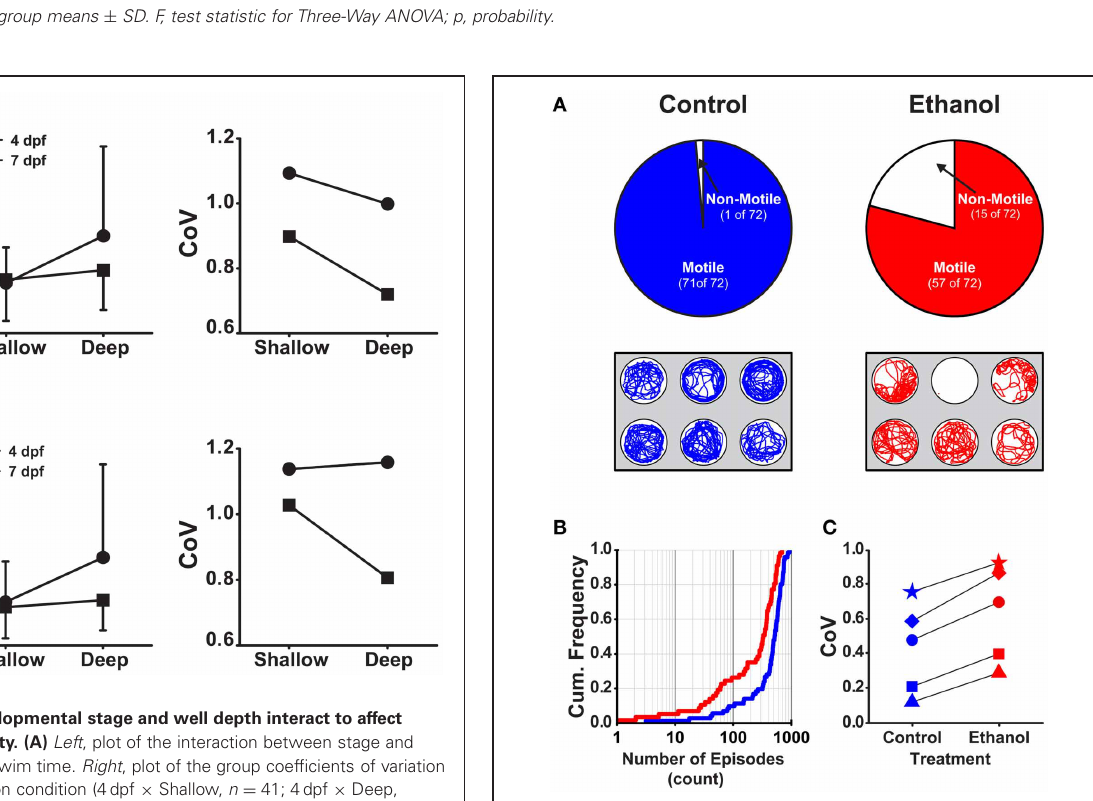
FIGURE 5 | The proportionof motile larvae and the variability among the locomotor properties are different for control and ethanol treated larvae (7dpf in deep behavioral wells). (A) Top Row , Pie charts depicting the proportions of motile and non-motile larvae in Control and Ethanol treated groups (blue and red, respectively). Bottom Row , Representative trajectory plots for larvae in 6-well behavioral arena plates (30mm well diameter shown); single larva per well. (B) Cumulative frequency plots for the number of swim episodes produced by Control and Ethanol treated larvae (blue and red, respectively). (C) Plots of the group coefficients of variation (CoV) for all measured locomotor properties for Control ( n = 71) and Ethanol ( n = 57) treated groups (blue and red, respectively). Symbols are: circle, episode frequency; square, episode duration; triangle, swim speed; diamond, active swim time; star, total